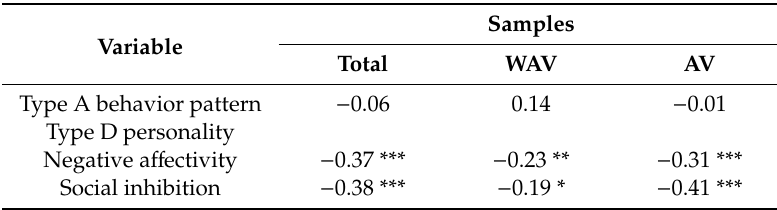
Table 4. Correlation of life satisfaction with personality types A and D.